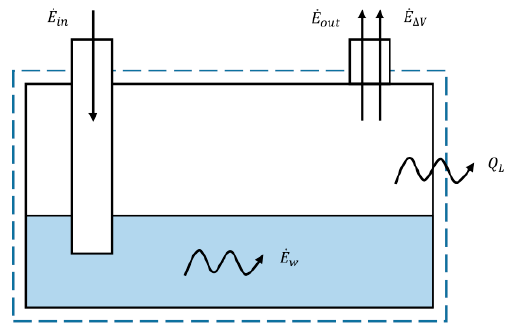
Figure 4. Energy balances for wet scrubber [39].